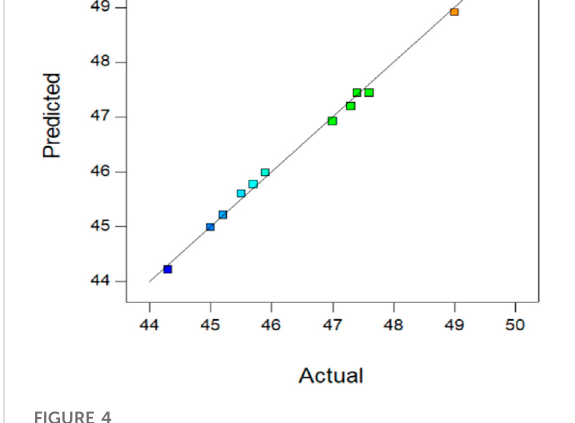
FIGURE 5 Extraction oil with DOP plasticizer.